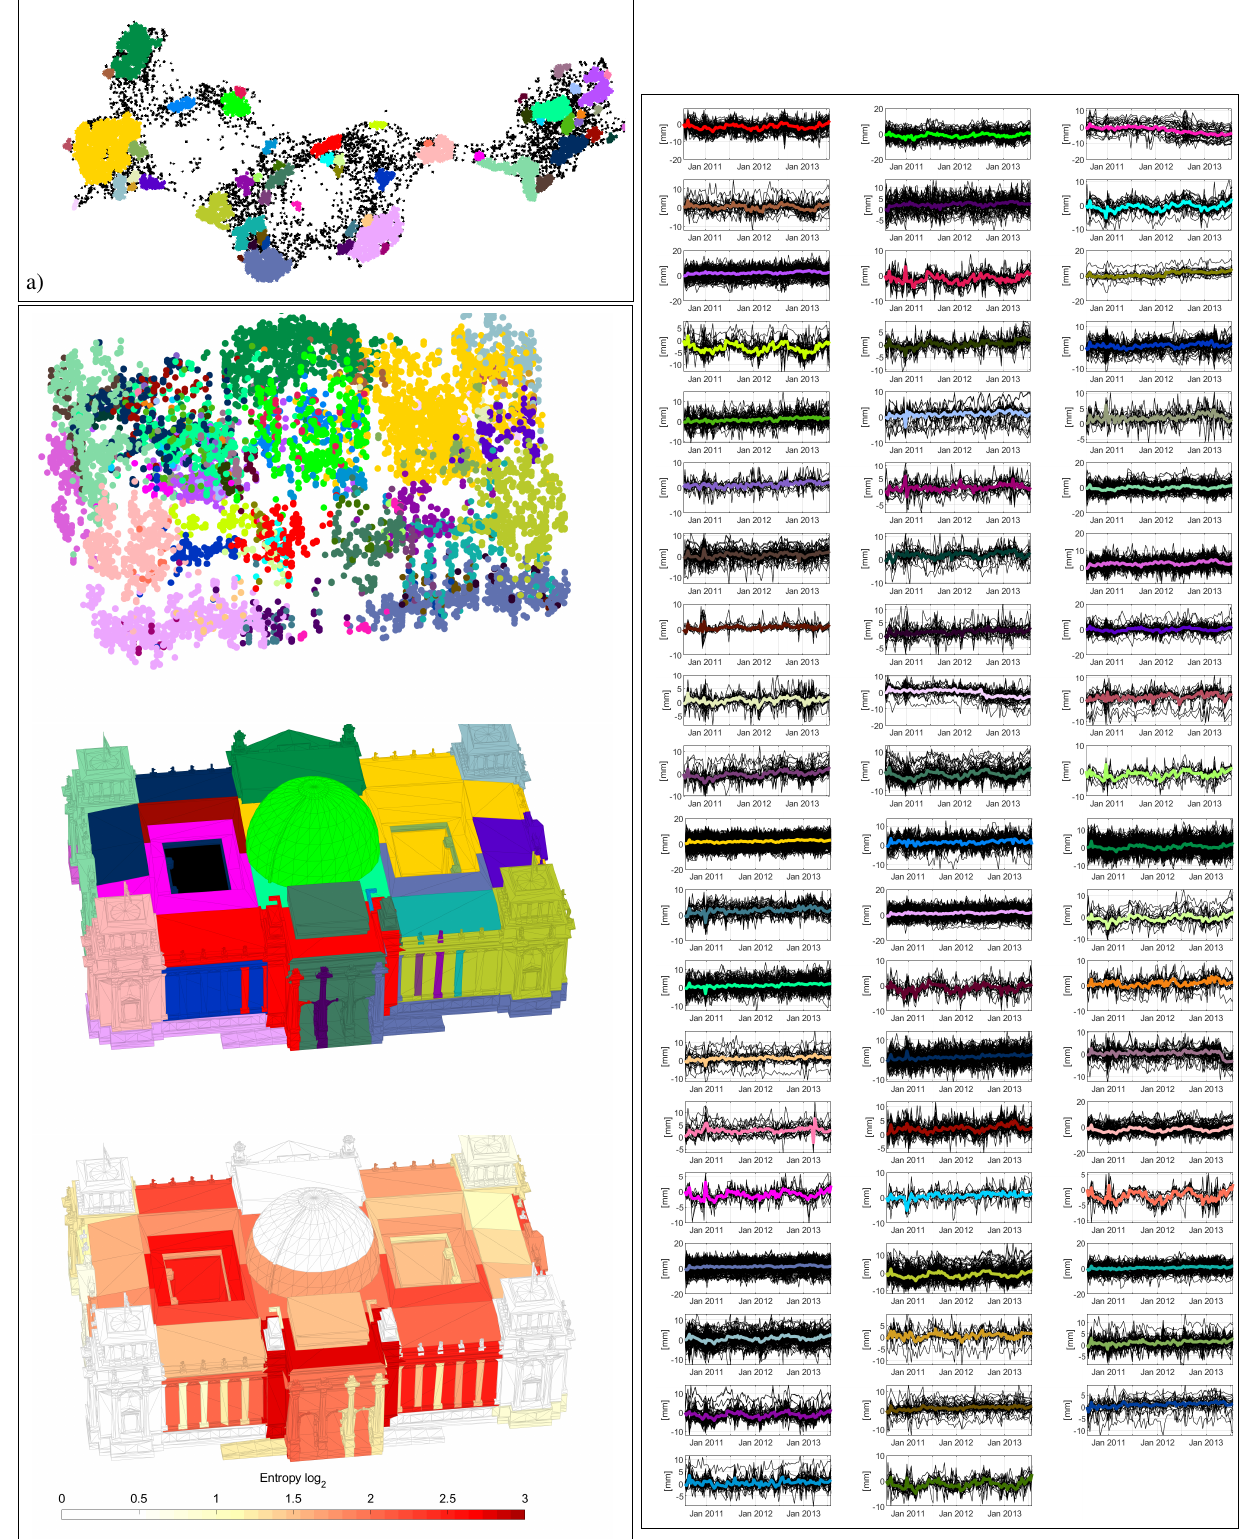
Figure 7. Time series for the extracted PS-clusters. The colored line indicates the mean deformation for the cluster. The colors correspond to Figure